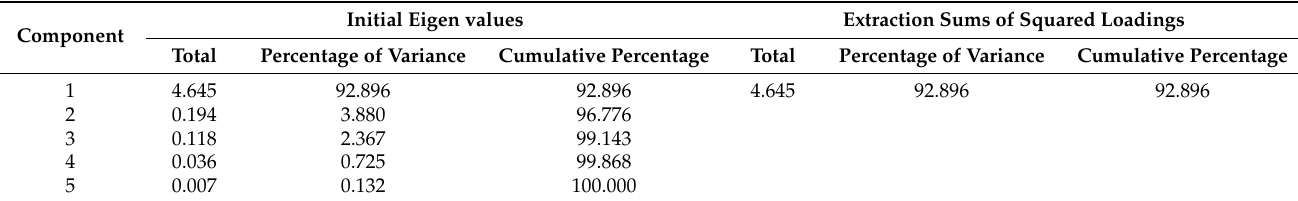
Table 11. Total variance explained.